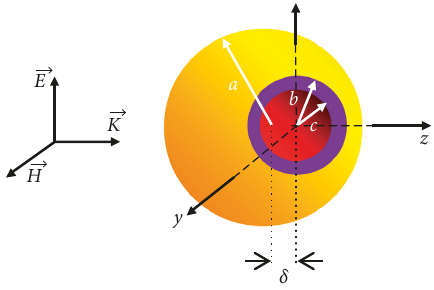
Figure 1: A schematic representation: a silicon/silica/gold spherical particle in space reported to the fixed coordinate system (O, x , y , and z ) is illuminated by an x -polarized plane wave propagating along the z -axis. The centre of the silicon/silica nanoshell is taken as the origin of coordinates. a , b , and c are the radii of the silicon sphere, the silica shell, and the gold shell, re- spectively. δ measures the offset between the centre of the gold shell and the centre of the silicon/silica